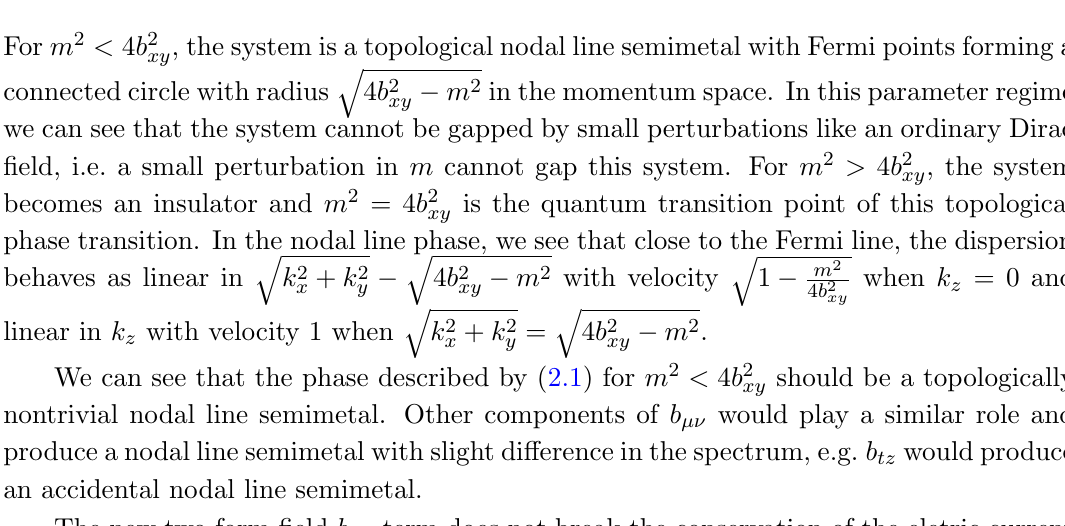
. Right: for m 2 > 4 b 2 the system is xy xy